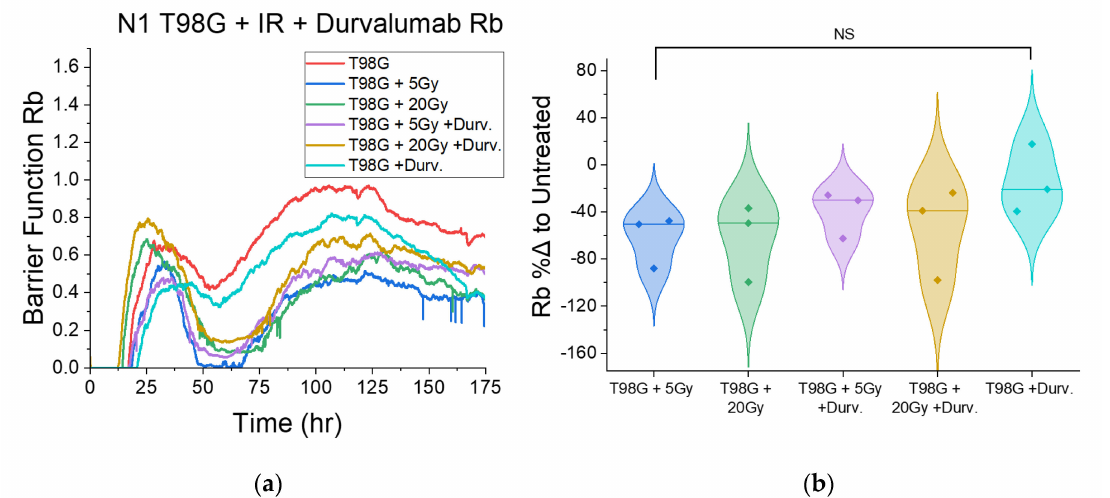
Figure 5. Barrier function-focused results of ECIS tests on T98G glioblastoma cells treated with radiation and durvalumab. ( a ) Representative plot of the barrier function R b post-treatment for T98G shown. ( b ) Violin plots of % differences in late R b for treated conditions, relative to the untreated control. The addition of durvalumab did not significantly affect the barrier function compared to irradiated controls. NS